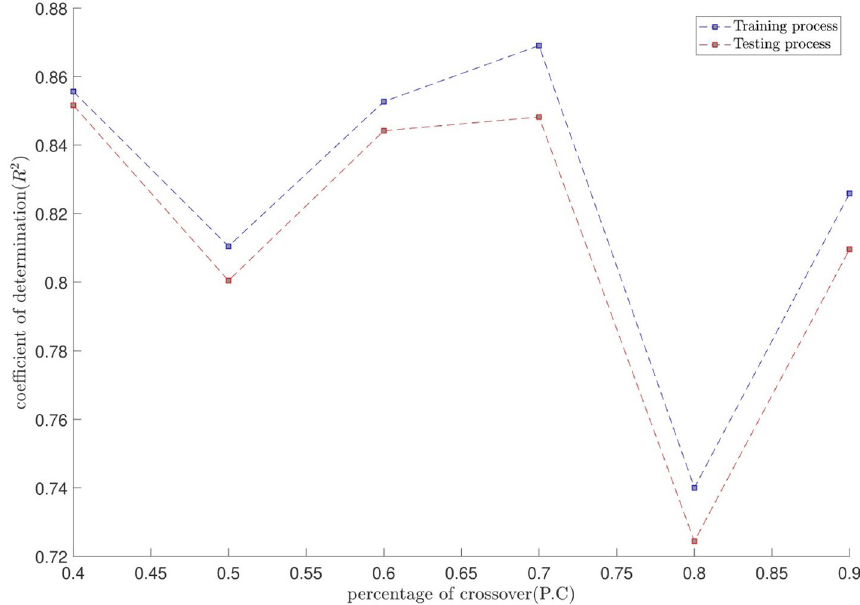
Figure 5. GAFIS method learning processes with changing in percentage of crossover (P.C).